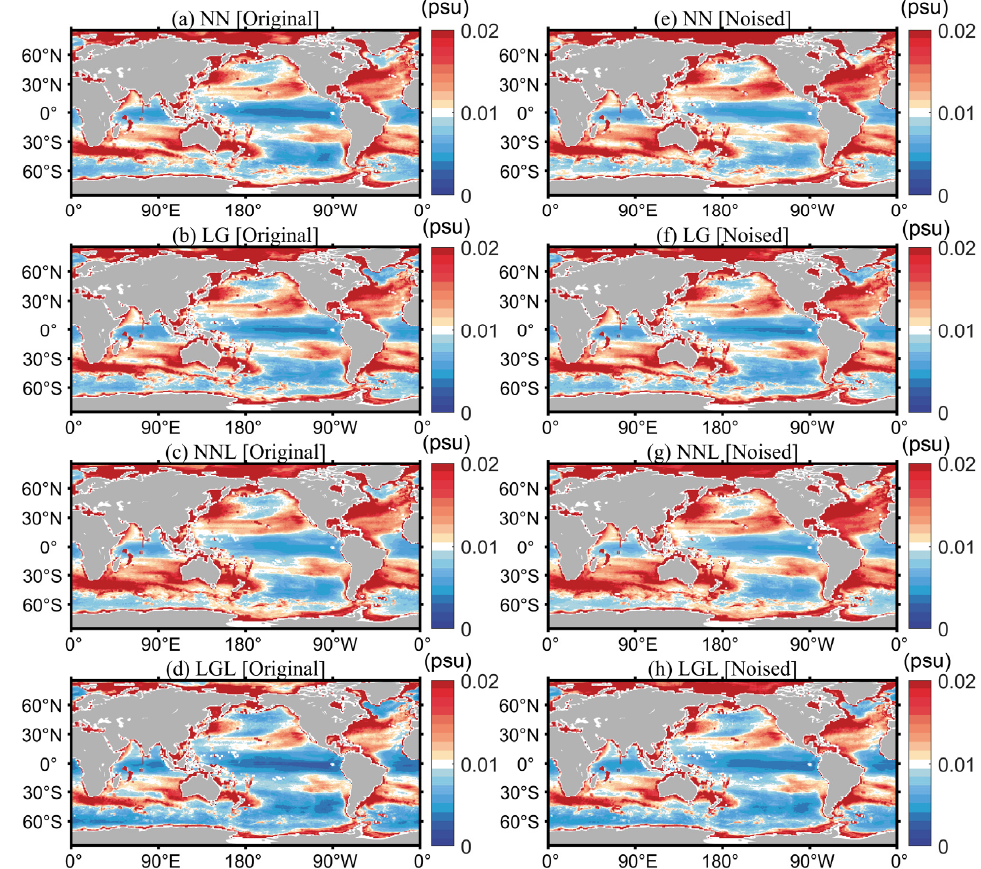
Figure 15. Spatial distributions of the average RMSEs in the 1–2000 m depth range of the four experiments. ( a – d ) Experiments performed with the original synthetic dataset. ( e – h ) Experiments performed with the noised synthetic dataset.